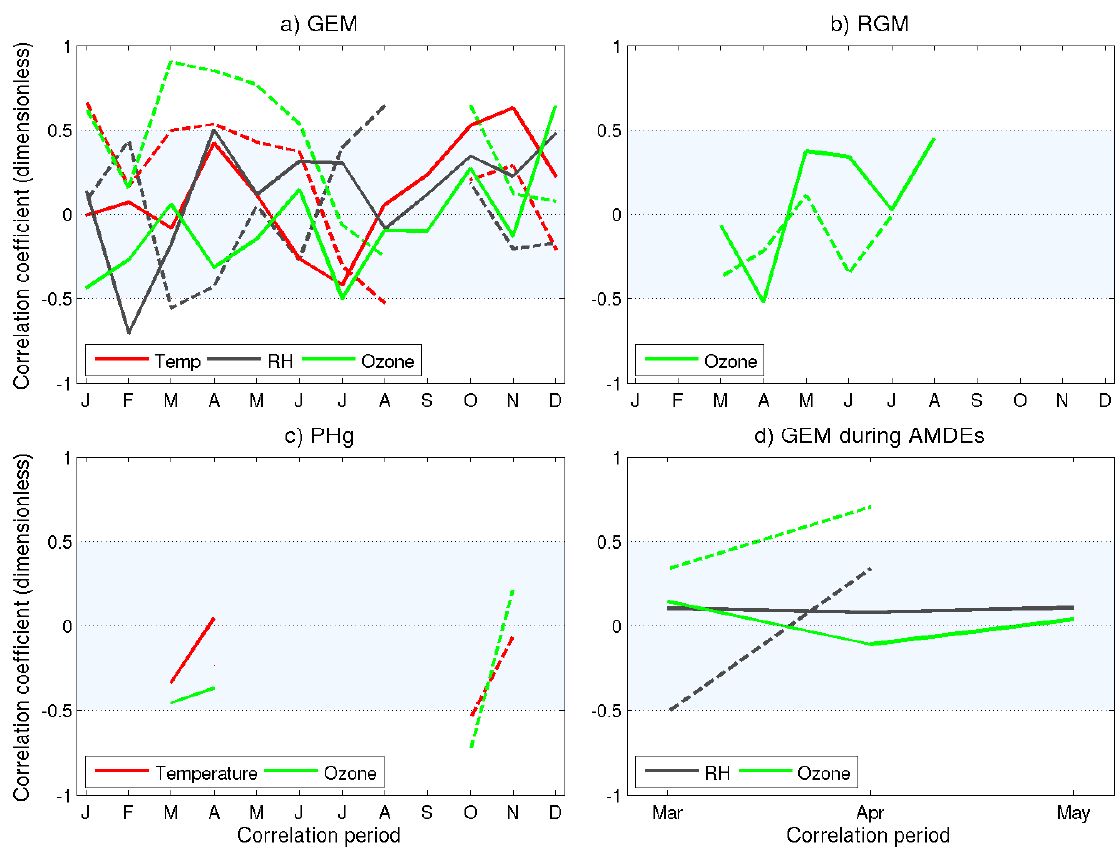
Fig. 7. Correlations of GEM, RGM and PHg concentrations with air temperature (Temp), relative humidity (RH), ozone and meridional wind. Solid lines represent correlation with high concentration ( < 75th percentile of the complete dataset) and dashed lines represent correlation with low concentration ( > 25th percentile of the complete dataset). (a) shows positive correlation of ozone and air temperature with low GEM concentrations during polar night, while relative humidity and high GEM concentrations anti correlate. The low GEM concentrations correlate with air temperature in January, March and April, and anti correlate with air temperature in August. Low GEM concentrations and ozone correlate in January, March–June and in October. Low GEM concentrations anti correlate with relative humidity in March and correlate with relative humidity in July and August. (b) shows a significant anti correlation of ozone with high RGM concentrations in April. (c) shows an anti correlation of air temperature and ozone with low PHg concentrations in October. (d) shows a correlation of ozone with strong AMDEs as spring